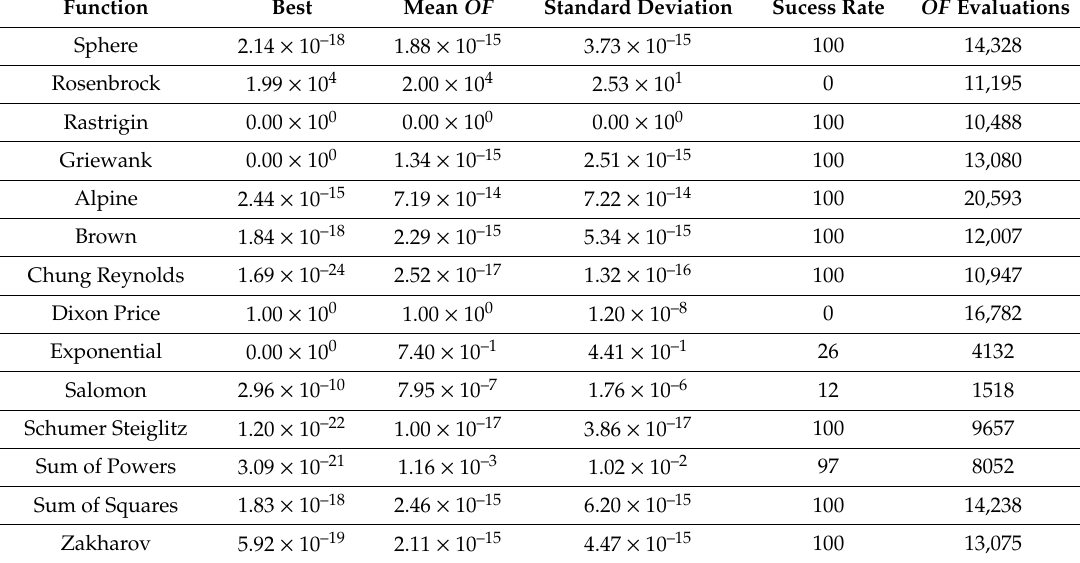
Table 5. Results of 100 runs with 20,000 variables using